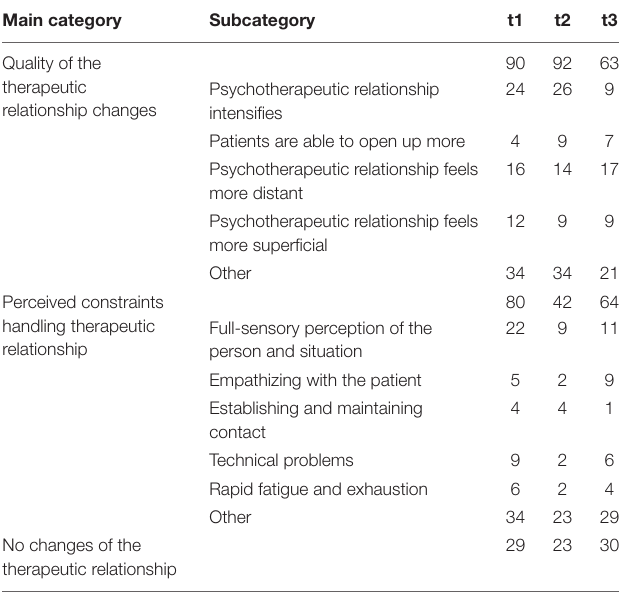
TABLE 3 | Main categories, selected subcategories and numbers for each test period t1–t3. Main